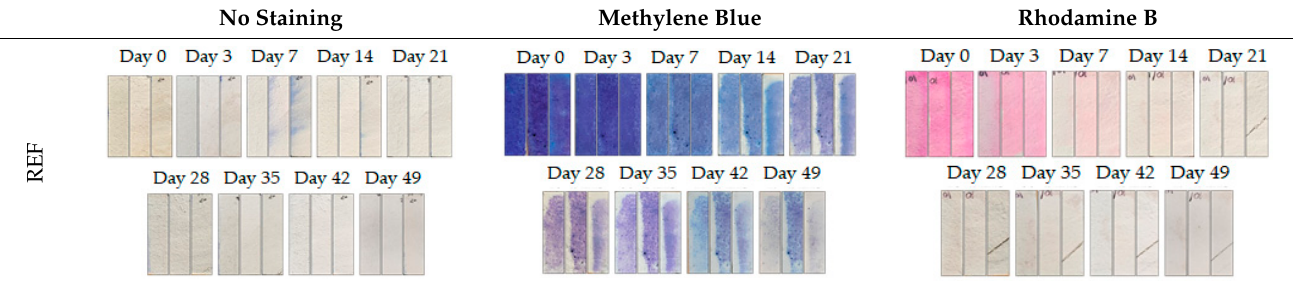
Figure 9. Analysis of the influence of TiO 2 content, with and without staining by rhodamine B, cured in an urban environment over time: ( a ) rutile, ( b ) anatase.